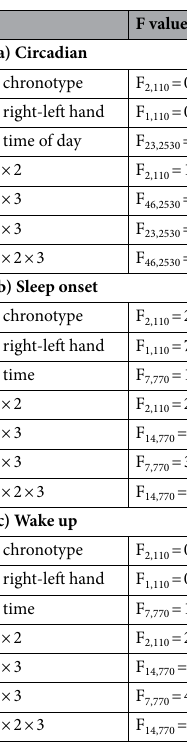
Table 1. Statistics of the mixed three-way analysis of variance on motor activity pattern during the 24 h (circadian, a), wake-sleep transition (sleep onset, b), and sleep–wake transition (wake-up, c).